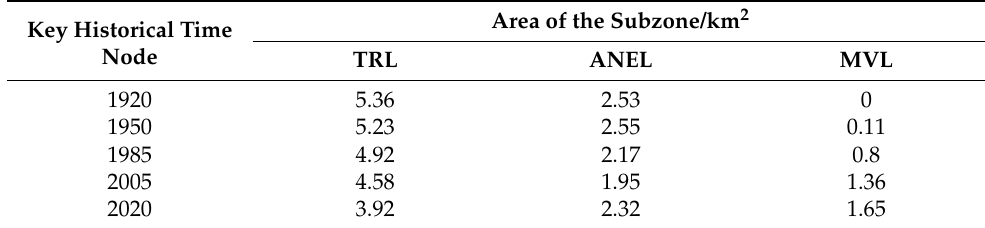
Table 2. Historical area of each subzone of the TAL Core Zone.